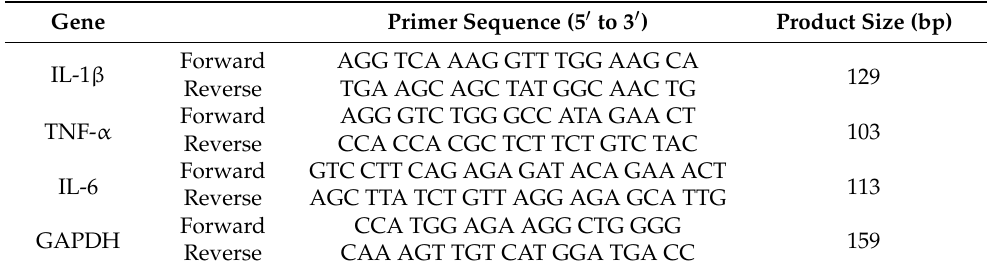
Table 1. Inflammatory cytokine primers for